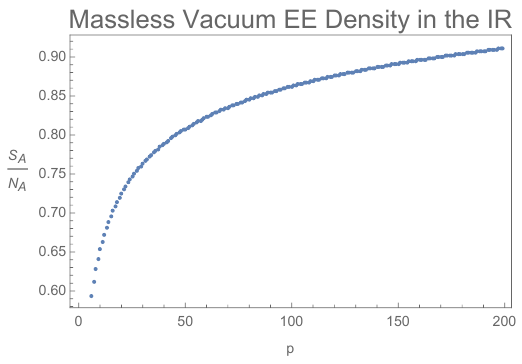
Figure 8: Asymptotic vacuum EE density of a deformed massless Lifshitz theory as a function of p . This is in the IR regime, in which the theory reduces to the massless z = 1 relativistic theory. divergence (3.33) holds for z = 1.